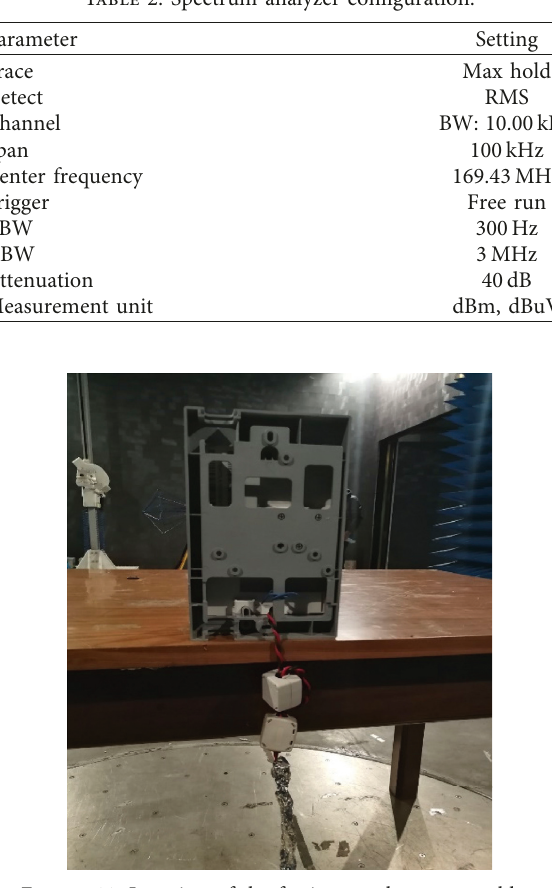
Figure 11: Location of the ferrites on the power cables.